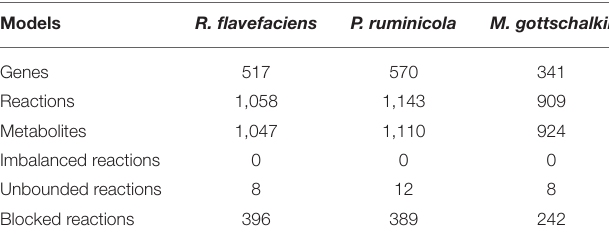
TABLE 2 | Model statistics after filling the gaps using GapFind-GapFill. Models